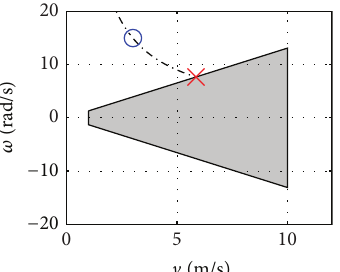
Figure 9: Region 2 example for second stage